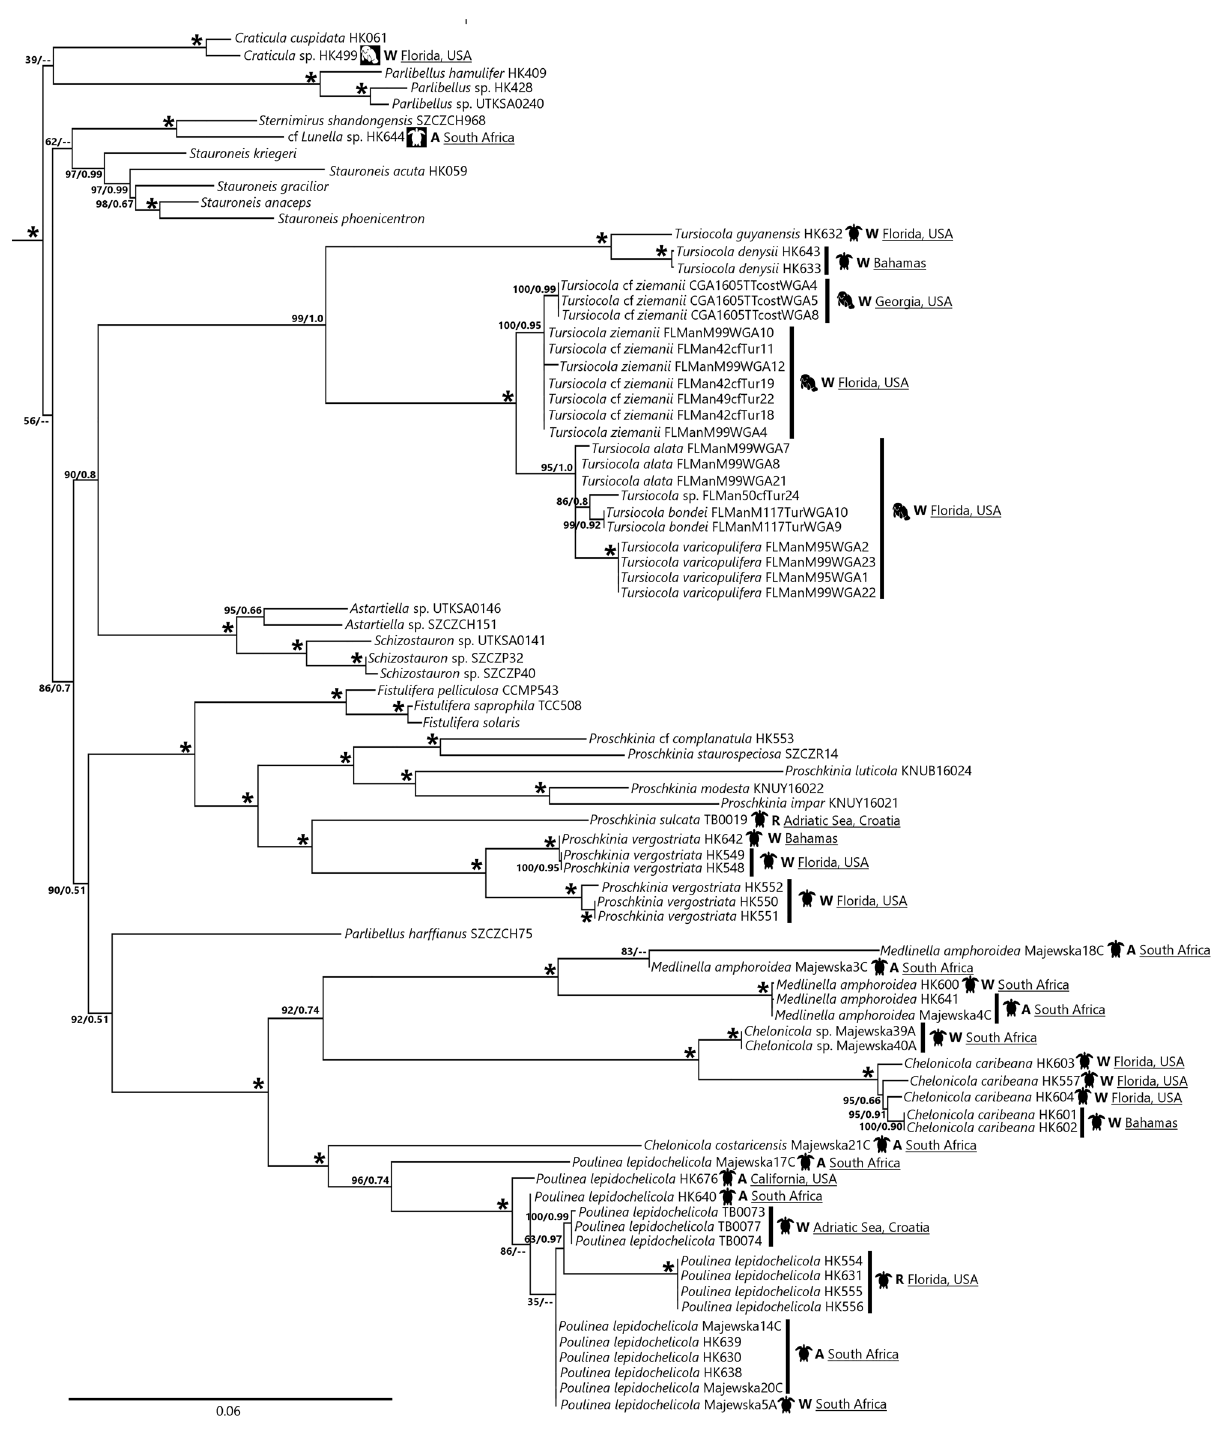
Figure 2. Maximum likelihood phylogenetic tree derived from a concatenated 3-gene DNA sequence dataset, representing the clade containing the Tripterion complex, Tursiocola and Proschkinia clades (complete tree shown in Fig. S1). Support values (ML bootstrap support/BI posterior probability) shown above nodes; “*” = nodes with 100%/1.0 values. Taxon name followed by DNA extraction voucher number or strain ID. Taxa isolated from epizoic habitats followed by a diagrammatic representation of the host from which the strain was isolated, and metadata on the location and setting in which the host was sampled (A = aquarium, R = rehabilitation facility, W = wild). Black host icon = POE taxon; white host icon = unclear habitat